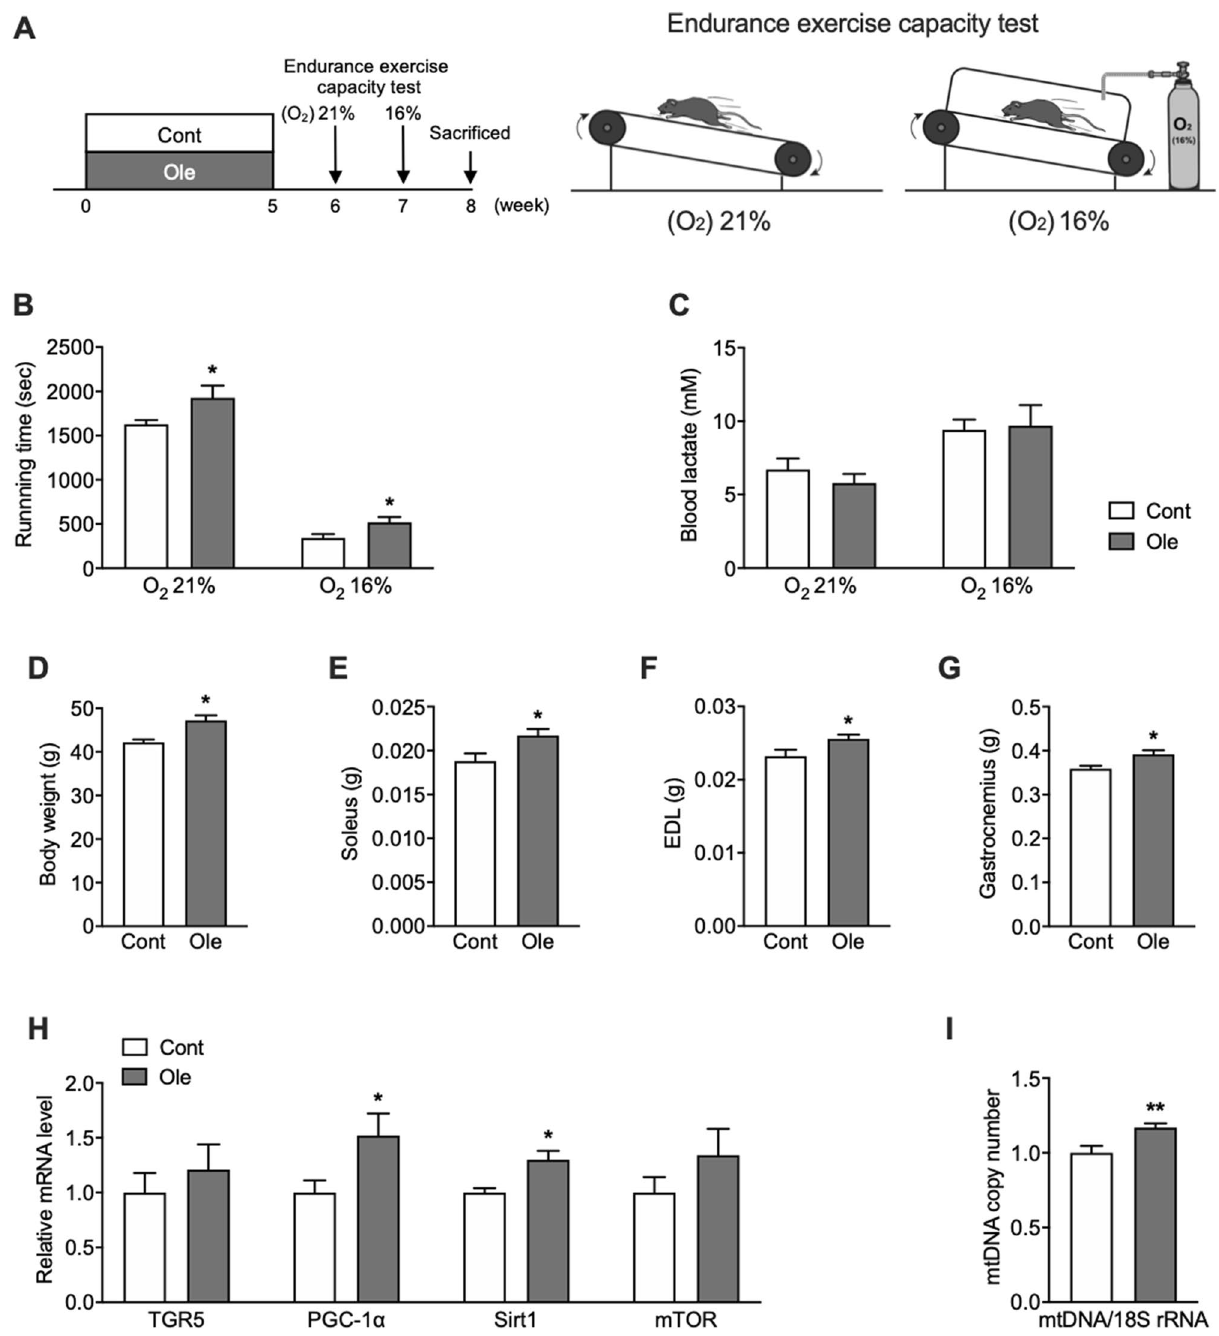
Figure 5. Olive leaf extract improved endurance exercise capacity under atmospheric (O 2 [21%]) and low O 2 (O 2 [16%]) conditions by enhancing mitochondrial mass in skeletal muscle. ( A ) Experimental protocol; ( B ) running times on a treadmill under standard (atmospheric) and low-O 2 (16% O 2 ) conditions; ( C ) blood lactate concentration just after exercise under standard (atmospheric) and low-O 2 (16% O 2 ) conditions; ( D ) body weight; ( E – G ) muscle weights of the soleus, EDL, and gastrocnemius; ( H ) mRNA expression levels of TGR5 , PGC-1α , Sirt1 , mTOR in the soleus muscle; and ( I ) mtDNA copy number in the soleus muscle. *p < 0.05 vs. control as determined by unpaired, two-tailed t